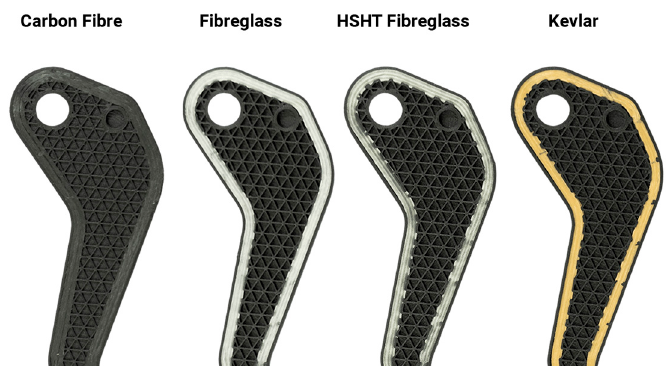
Figure 1. Presentation of cross-sections of composite prints using various reinforcing materials, from the left: carbon fiber, glass fiber, high-strength high-temperature glass fiber and Kevlar [16].